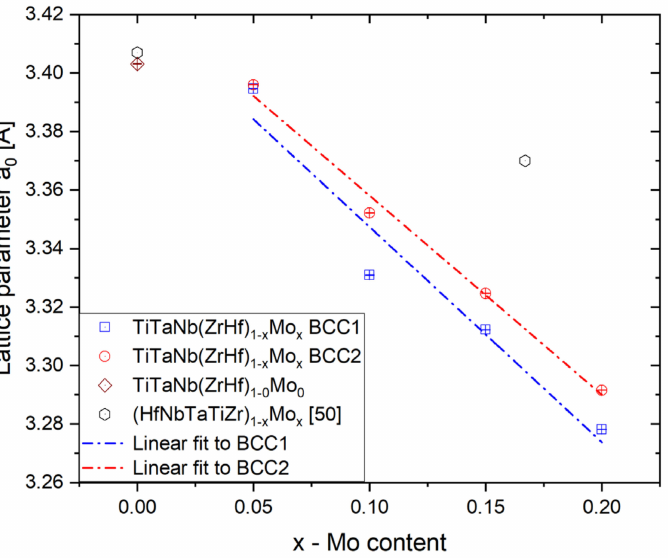
Figure 3. The changes of lattice parameters of dendritic (BCC1) and interdendritic (BCC2) phases with different Mo content for all studied high entropy alloys. Table 4. SEM Energy-Dispersive X-ray Spectroscopy (EDS) chemical compositions (at.%) and cal- culated melting temperature (T(m)) for all studied high entropy alloys for dendritic (BCC1) and interdendritic (BCC2)